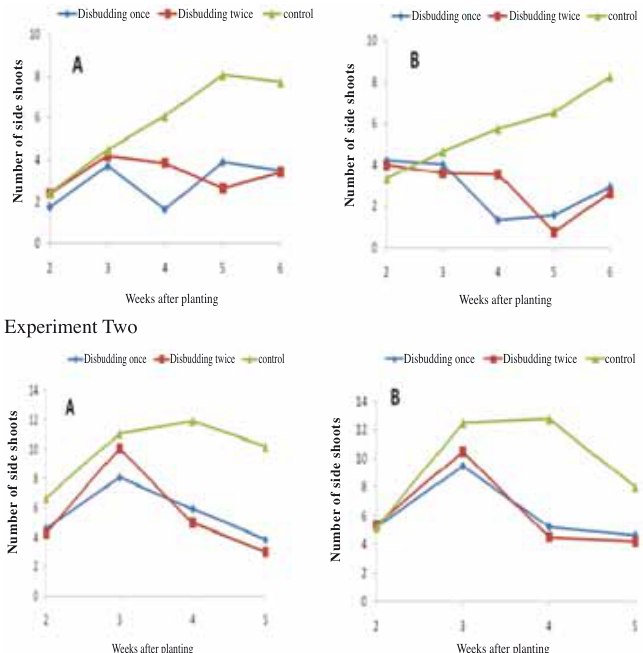
Fig. 2 - Effects of disbudding and cultivar on side shoot production: ‘Carmine’ (A) and Chief Gold’ (B) cultivars of celosia over the growing period in both experiments.